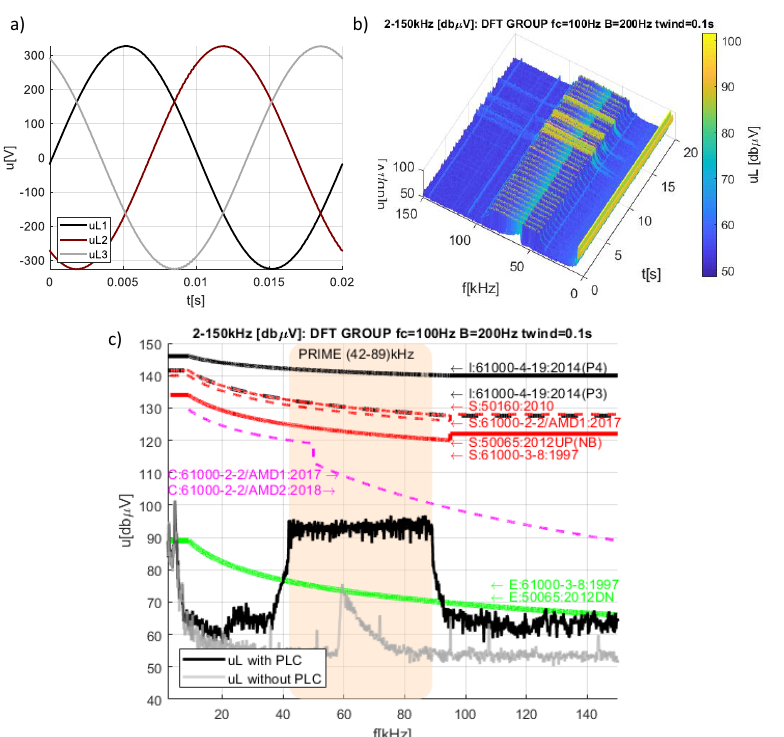
Figure 8. Case 2: results of the analysis of PRIME PLC system operation with LED light sources at